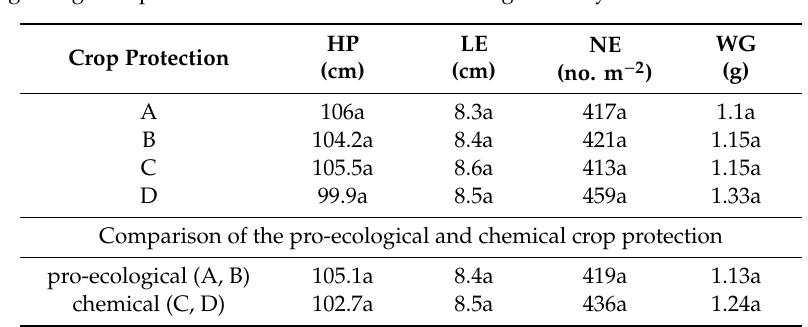
Table 4. The impact of crop protection system on selected yield components of the spelt wheat cv. “Rokosz” (mean for 2013–2015). HP—height of plant, LE—length of ear, NE—number of ears per m 2 , WG—weight of grains per ear. The same letter means not significantly di ff erent values.